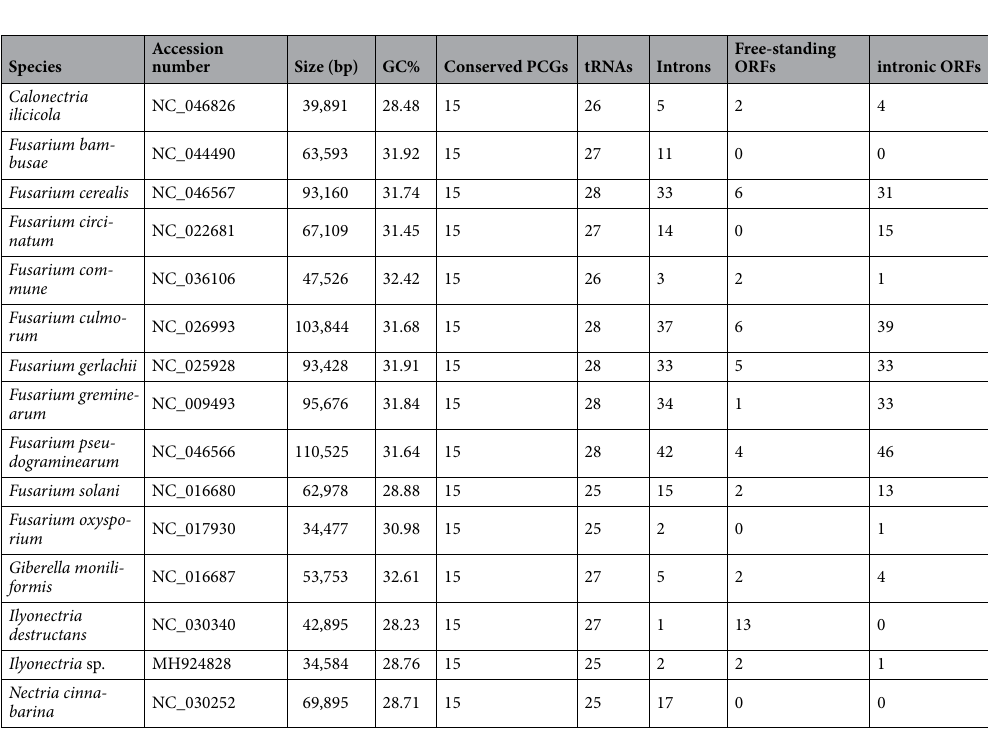
Table 2. Basic characteristic of Nectriaceae mitogenomes. Species names arranged alphabetically. PCG’s- Protein Coding Genes; ORFs—Open Reading Frames.